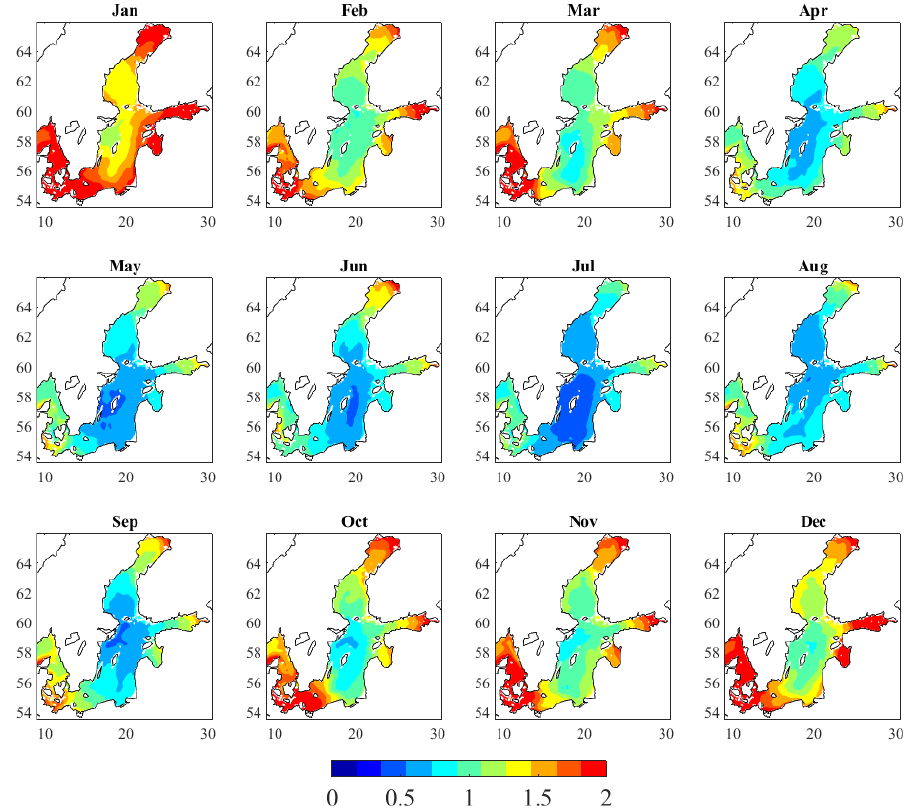
Figure 4. MSSHR m, 10y – monthly maximum ranges (m) for each month over 10 years (2007–2016) of reanalysis data. The red areas illustrate MSSHRs higher than about 1.8m, up to 4m.